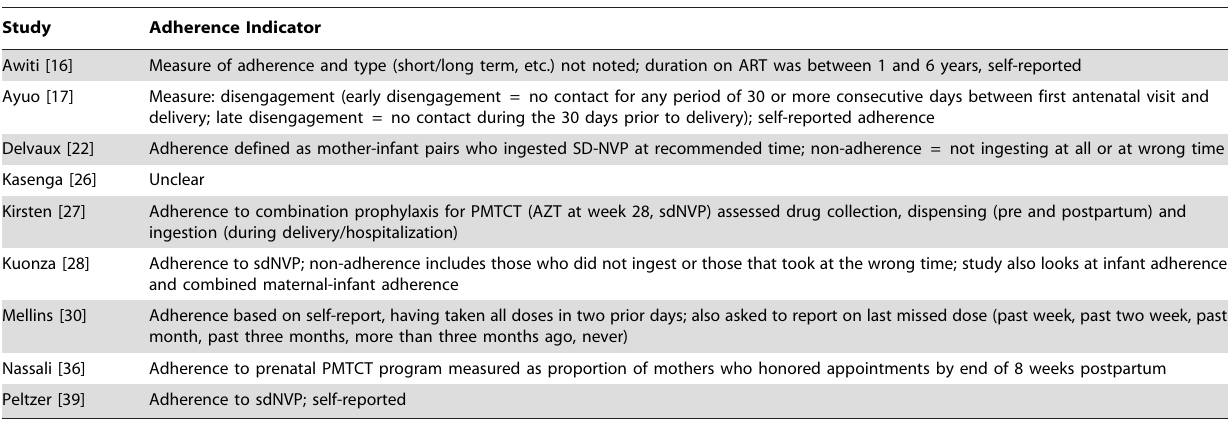
Table 2. Indicators of Adherence Used in the